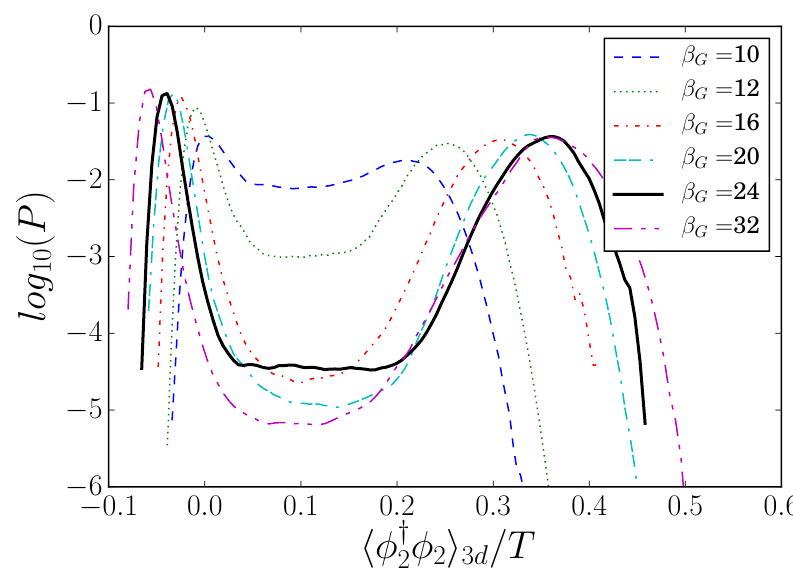
(cid:30) 2 i 3d in BM1, 2